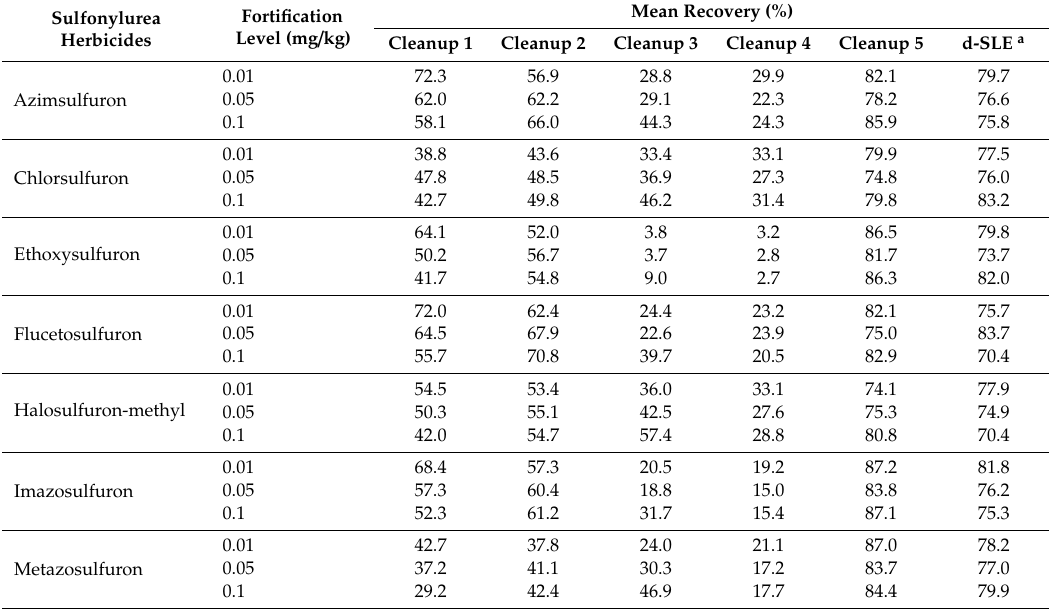
Table 3. Comparing selected sulfonylurea herbicide recoveries from strawberries using five dispersive solid phase extraction (d-SPE) cleanup procedures and the optimized d-SLE